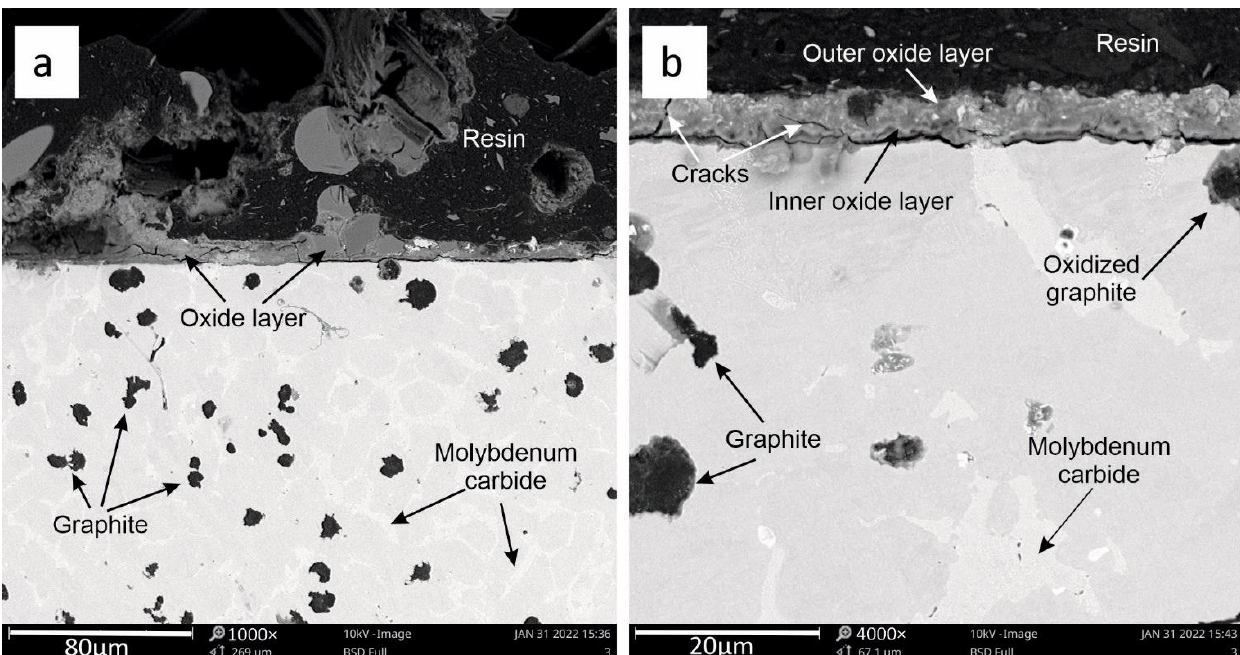
Figure 11. View of the oxide layer after three heating cycles ( a ) for sample 3. Detailed description of the oxide layer ( b ).